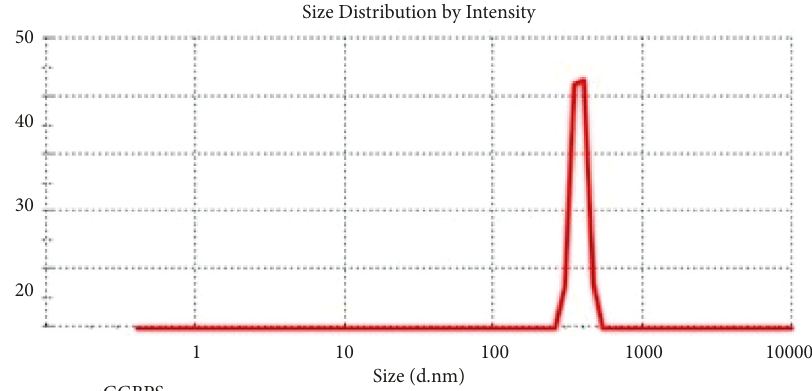
Figure 4: Size analysis using zeta analyzer.